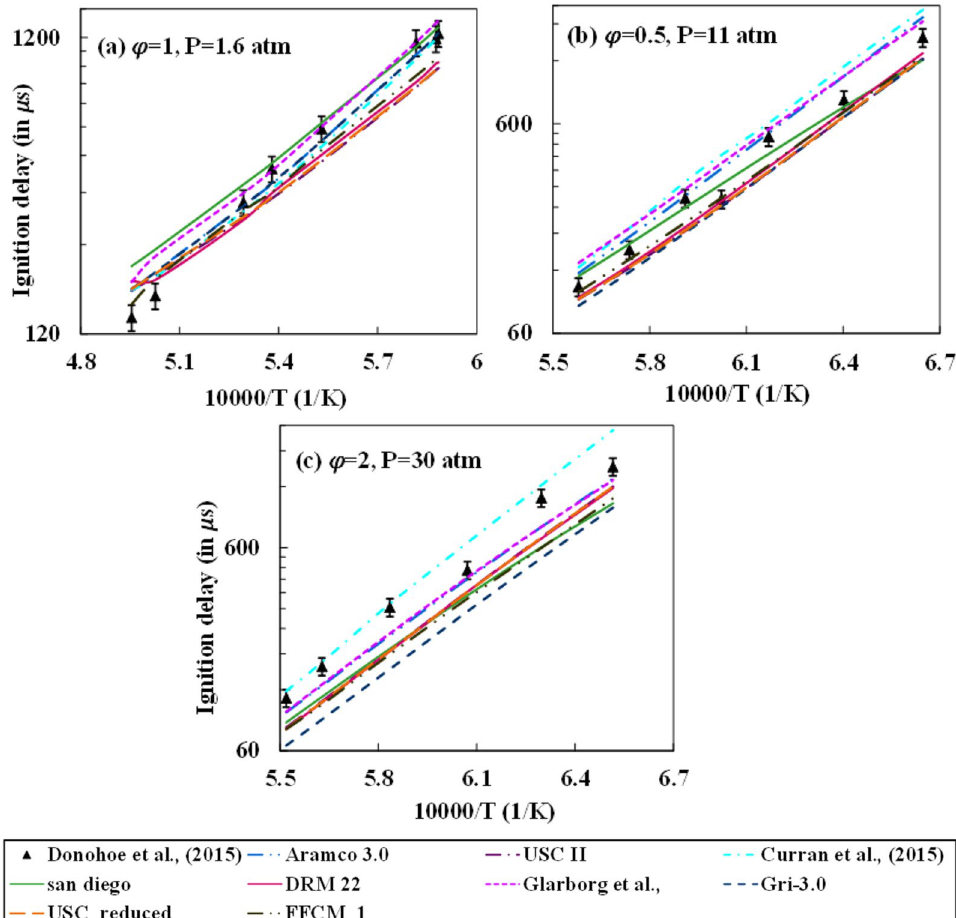
Figure 2. Comparison between different mechanisms for 10% steam dilution and CH 4 /Argon/O 2 mixtures with 98% Argon by